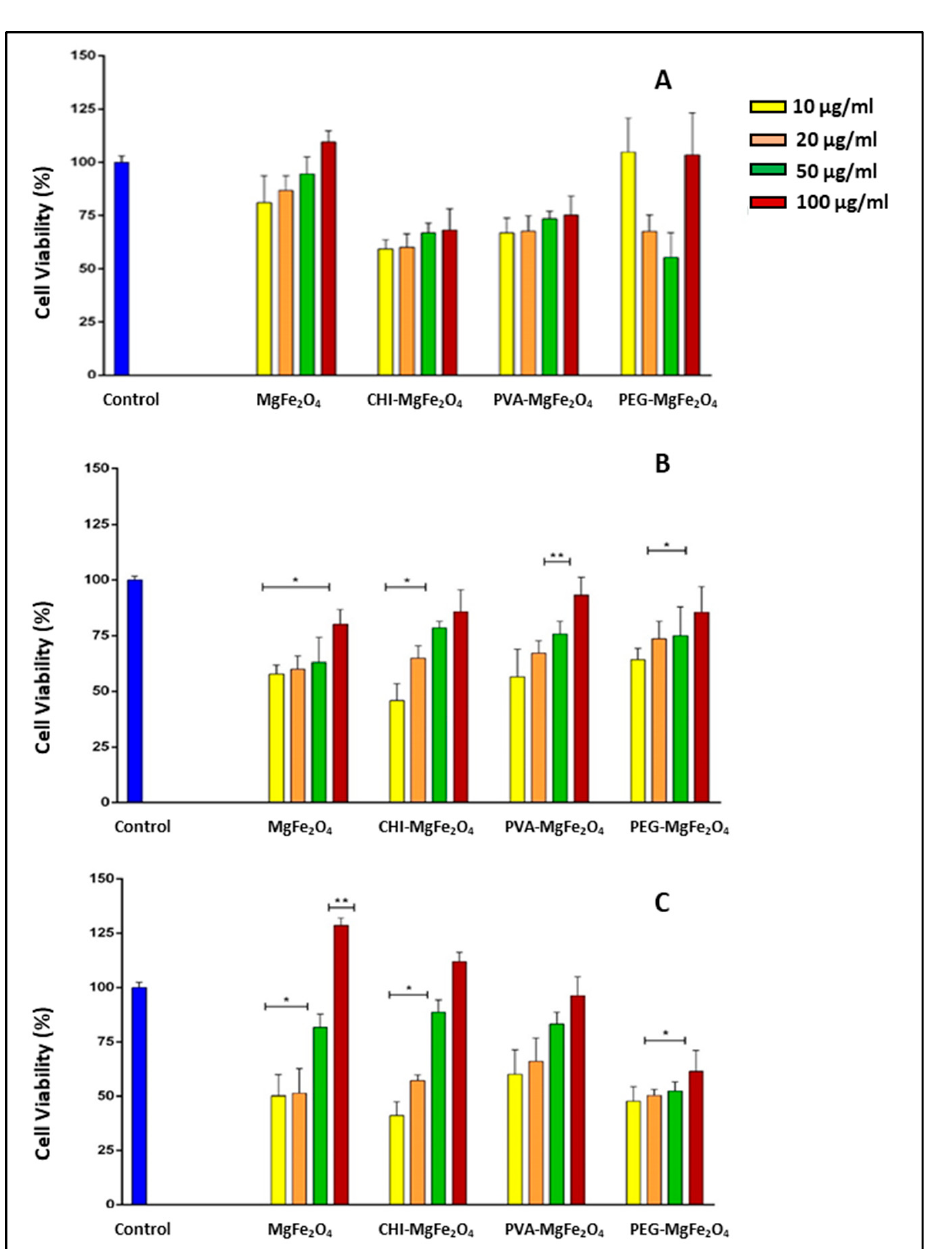
Figure 6. Cytotoxic profile for MgFe 2 O 4 , CHI-MgFe 2 O 4 , PVA-MgFe 2 O 4 and PEG-MgFe 2 O 4 MNPs in the ( A ) HEK293, ( B ) Caco-2 and ( C ) SKBR-3 cell lines, respectively. Data represented as means ± SD ( n = 3), where * p < 0.05 and ** p < 0.01 are considered to be statistically significant. Table 5. IC 50 ( µ g) values for DOX-loaded MNPs and free DOX. Drug